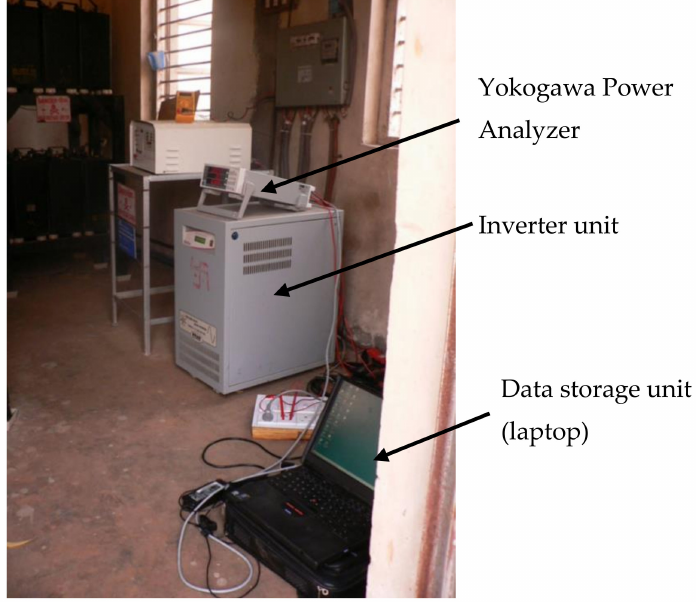
Figure 5. Load profile of the existing distribution system of Rajmachi village.